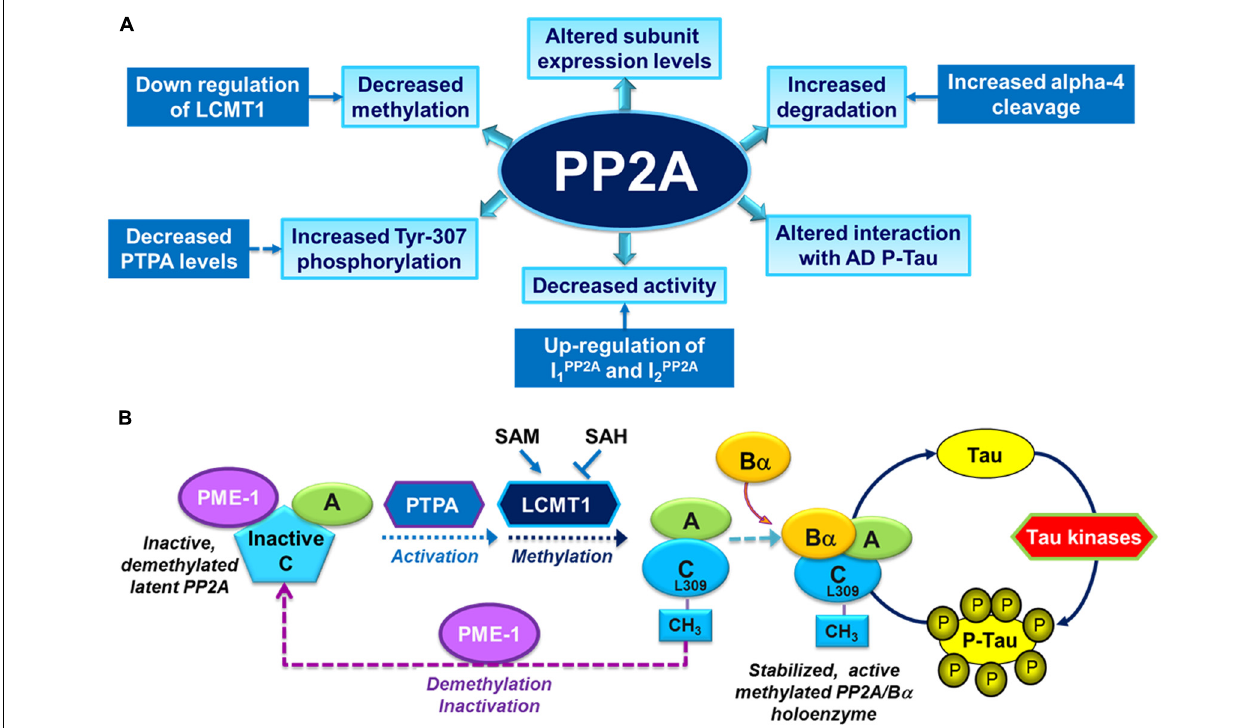
FIGURE 2 | Overview of PP2A dysfunction in AD and its link with the deregulation of tau. (A) Altered PP2A subunit expression, activity and post-translational modifications have been described in AD autopsy brain tissue. Some of these changes may be mediated by alterations in specific PP2A modulatory proteins (LCMT1, PTPA, alpha4) and endogenous PP2A inhibitors (I 1PP2A and I 2PP2A ) that have also been reported in AD autopsy brain tissue. They also decrease the interaction of PP2A with tau. (B) The biogenesis of the PP2A/B α holoenzyme, the primary Ser/Thr tau phosphatase in vivo , is believed to be controlled by Leu-309 methylation of PP2A catalytic subunit by LCMT1. This reaction requires the supply of